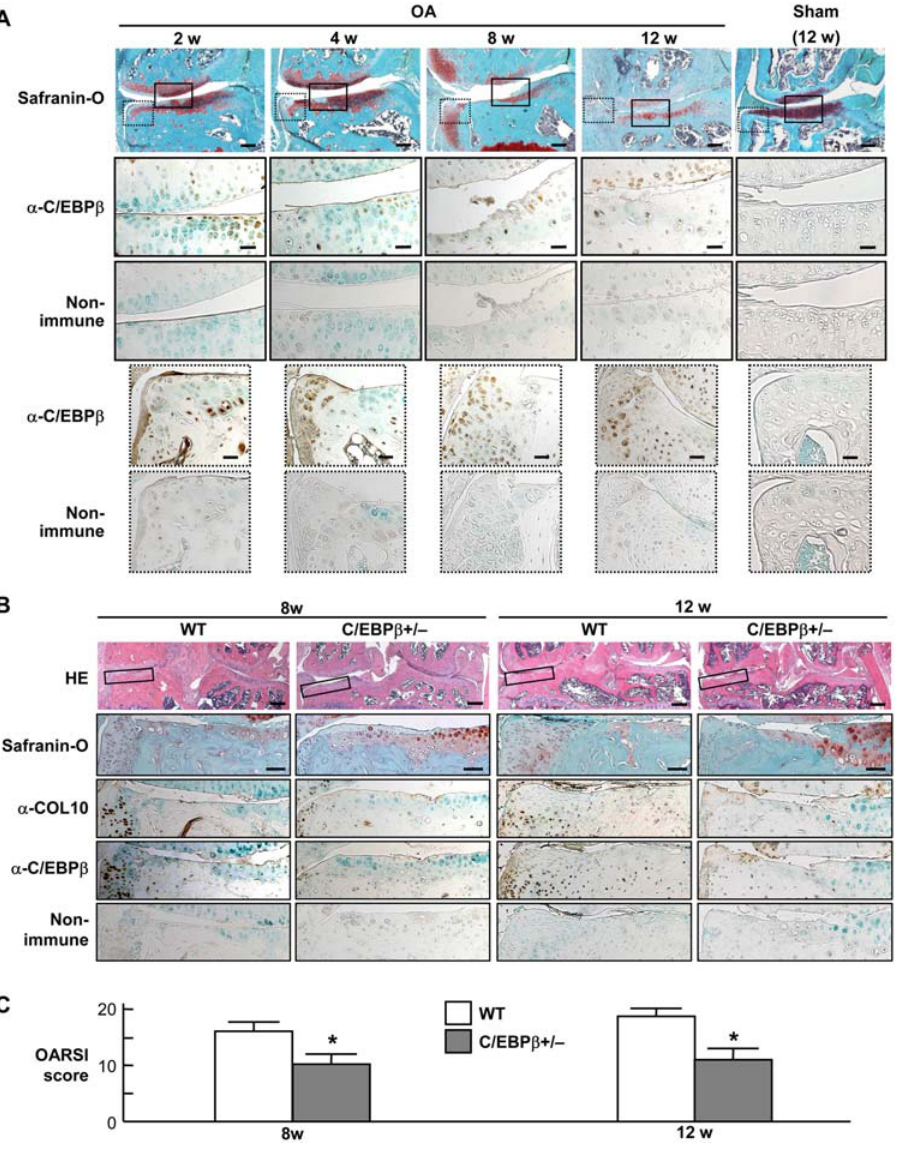
Figure 6. C/EBP b is involved in cartilage destruction during osteoarthritis progression . (A) Time course of joint cartilage destruction and C/EBP b expression in the medial portion of cartilage after creating an experimental osteoarthritis model that induces instability to the knee joints of 8-week-old wild-type mice. Safranin-O staining and immunohistochemical staining with an antibody to C/EBP b ( a -C/EBP b ) or the non-immune control IgG were performed at the indicated weeks after surgery. A sham operation was performed using the same approach, and assessed after 12 weeks. Boxed areas with solid and dotted lines in the top row indicate the regions of the other rows. Scale bars, 100 m m (top) and 400 m m (others). (B) HE and Safranin-O stainings, and immunohistochemical stainings with a -C/EBP b and a -COL10 or the non-immune IgG in the tibial cartilage of wild-type (WT) and C/EBP b + / 2 littermates 8 weeks and 12 weeks after the surgery. Boxed areas in the top row indicate the regions of the other rows. Scale bars, 200 m m (top), 400 m m (others). (C) Cartilage destruction according to the OARSI grading system. Data are expressed as means (bars) 6 SEM (error bars) for 5 mice per genotype at 8 and 12 weeks. *P , 0.05 vs. WT